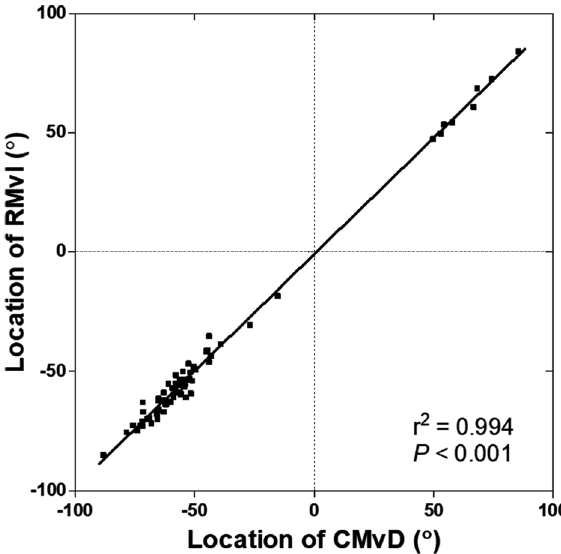
Figure 1. Topographic correlation between RMvI and CMvD. Positive and negative values indicate superior and inferior locations relative to the foveal-disc axis,